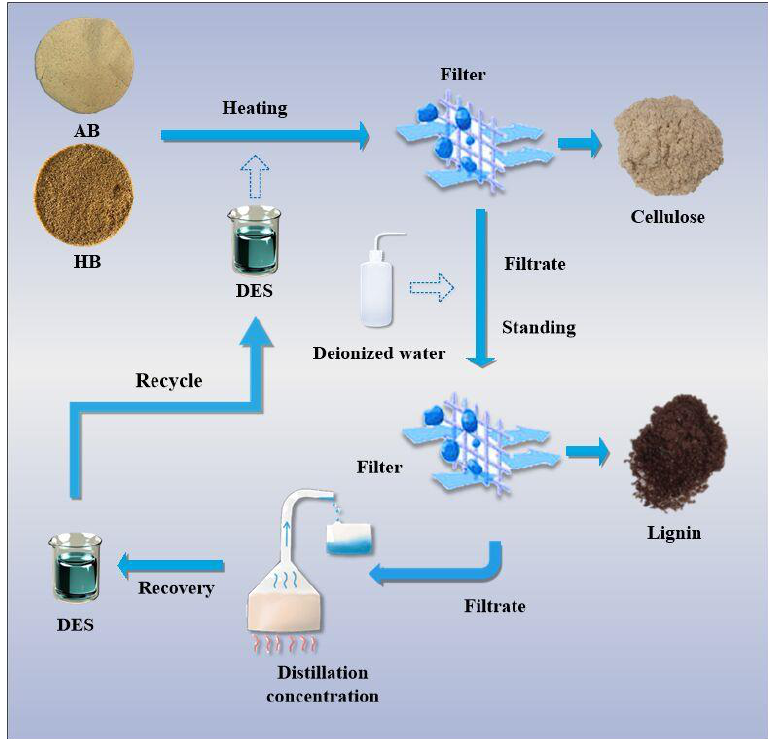
Figure 2. Flow chart of DES separation of lignin and cellulose.